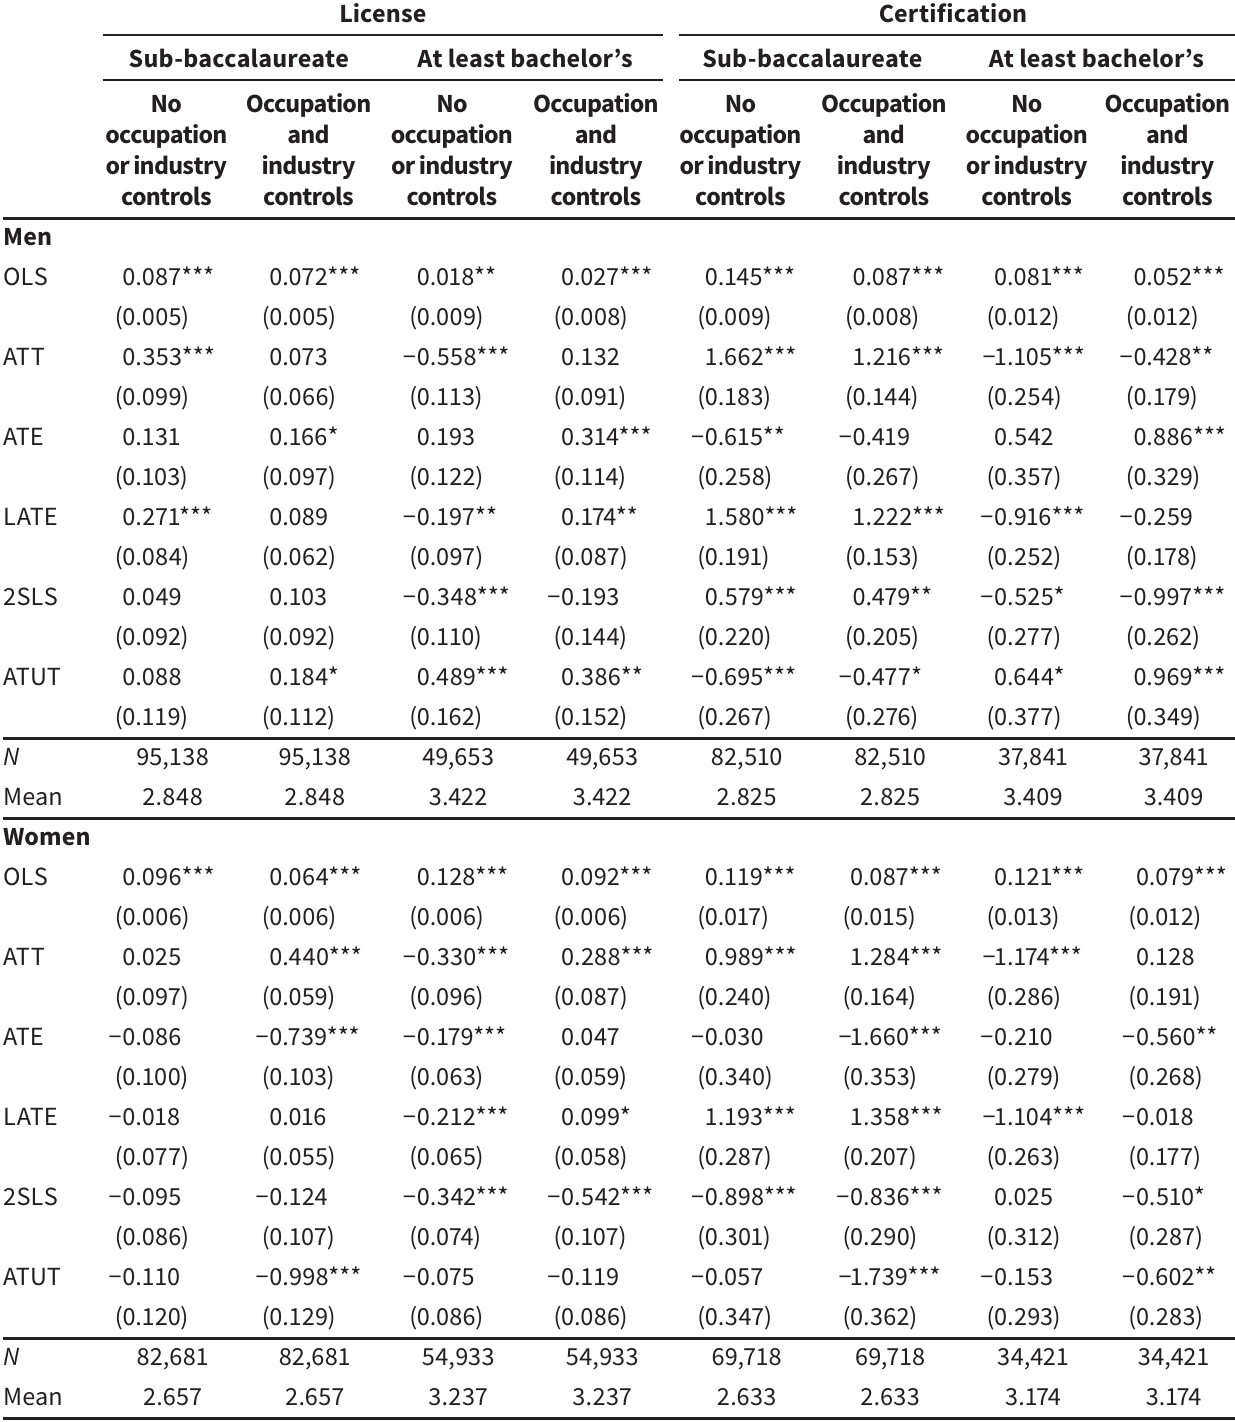
Effects of credential-holding on log wages by gender and level of